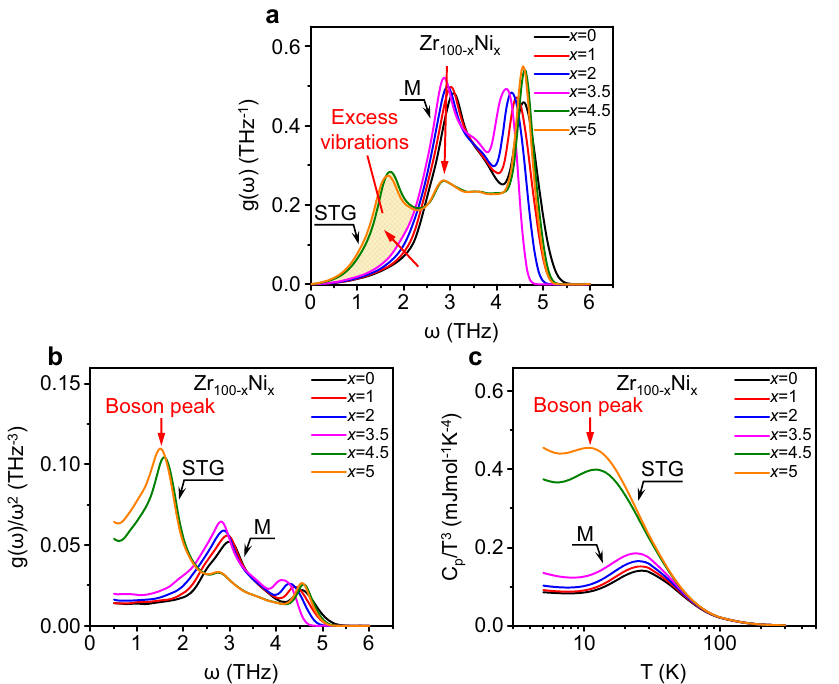
Fig. 3 BP-like anomaly reproduced by simulation. a Vibrational density of states (VDOS) g ( ω ) as a function of frequency ω for each x in a strain glass model system (Zr 100 − x Ni x ). b Reduced VDOS g ( ω )/ ω 2 as a function of ω for each x . The boson peak is observed around 1.5 THz for strain glass. c The plot of C p / T 3 vs. T calculated by the